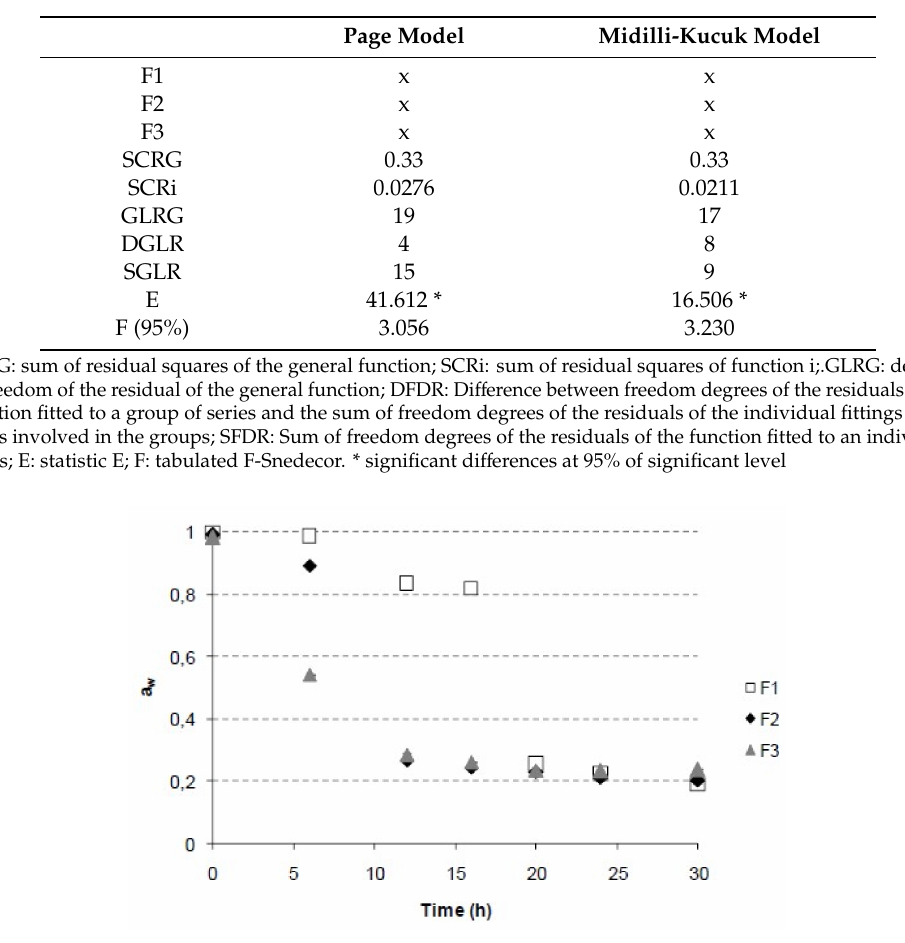
Figure 2. Water activity evolution along kinetic freeze-drying of grapefruit